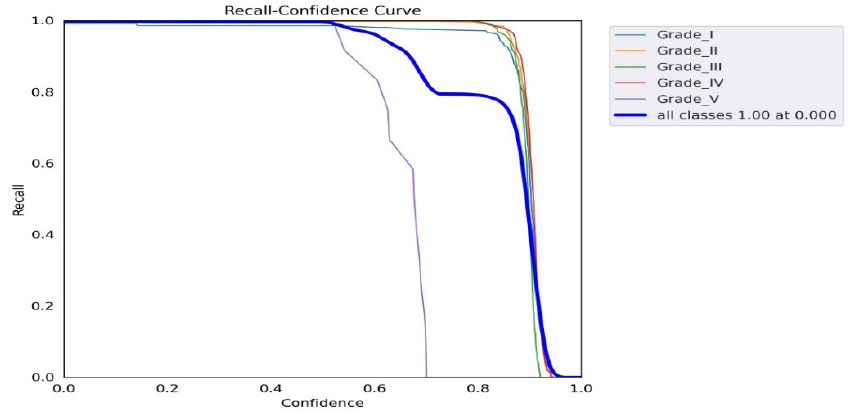
Figure 11. Precision–confidence graph showing the relationship between precision and confidence.